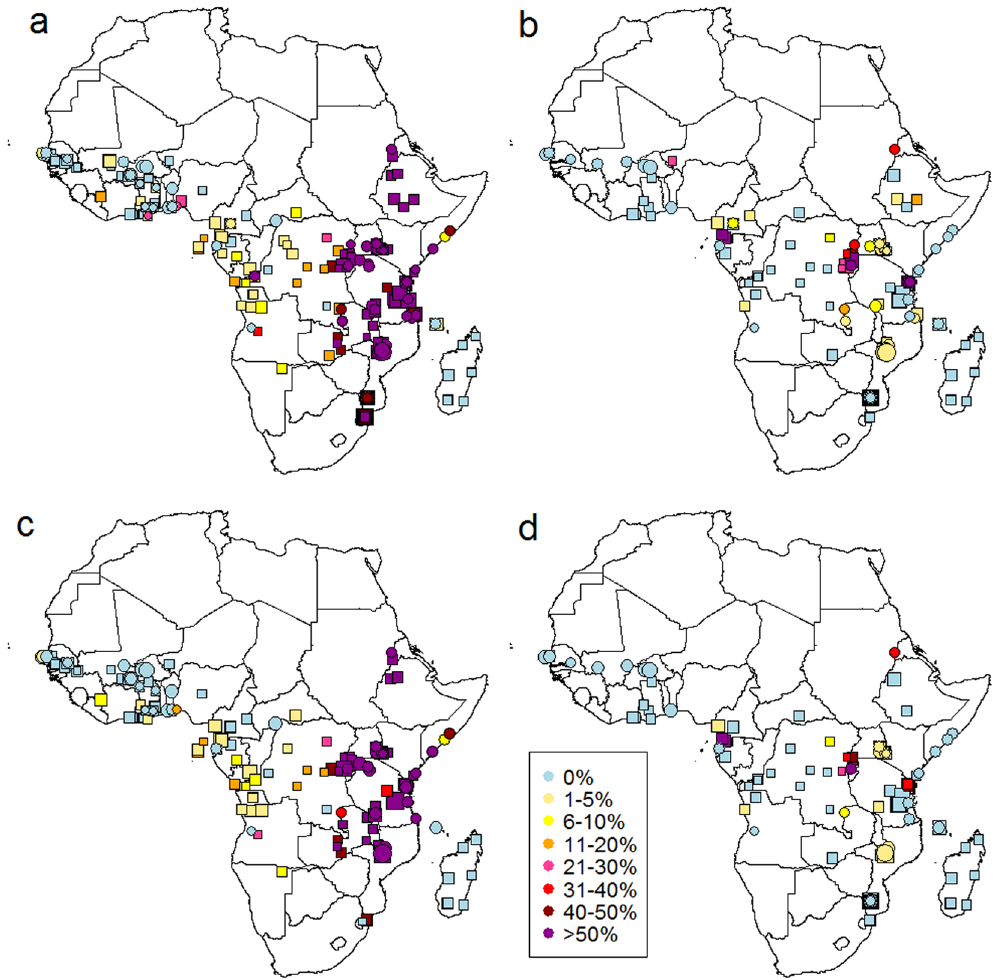
Figure 2. Prevalence of dhps ( A ) 540E and ( B ) 581G in infected individuals and estimated frequencies of ( C ) 540E and ( D ) 581G mutations in parasite populations in Africa 2004–2008 (squares) and 2009–2013 (circles) (see also Supplementary data 1 and 2). Data point size is proportional to sample size, with most recent data on top. ( A ) 540E prevalence was assessed in 294 surveys in 32 countries since 2004, of which only 6 did not detect the mutant at all: Burkina Faso, Gambia, Côte d’Ivoire, Madagascar, Niger, Swaziland. Nine countries detected 540E prevalence > 50%: Sudan, Somalia, the Republic of the Congo, Tanzania, Malawi, Kenya, DRC, Mozambique, Ethiopia, Rwanda, Uganda and Zambia. ( B ) 581G prevalence was assessed in 147 surveys in 26 countries, of which 13 countries detected the mutation: Angola, Cameroon, Democratic Republic of the Congo, Ethiopia, Equatorial Guinea, Kenya, Malawi, Niger, Rwanda, Sudan, Tanzania, Uganda and Zambia. ( C and D ) Frequencies are shown only for surveys which reported the prevalence of mixed infections (27% of total surveys), or estimated frequency by excluding mixed infections from analysis (21%), or had zero prevalence (32%). Surveys which counted mixed infections as mutants (11%), or did not specify how mixed infections were dealt with (8%) were excluded. Frequencies are estimated using Method 5C (Methods section, equation 8), assuming the probability of detecting each clone was 0.54. Maps were generated in R software version 3.1.3 62, 61 and are based on 180 publications (62 since 2011). Similar patterns are confirmed by an independent review of 35 publications carried out after our review was complete 63